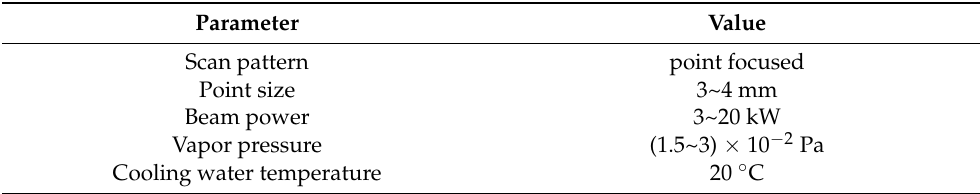
Table 2 lists the common process parameters of the EBM process. Table 2. Parameters of the EBM